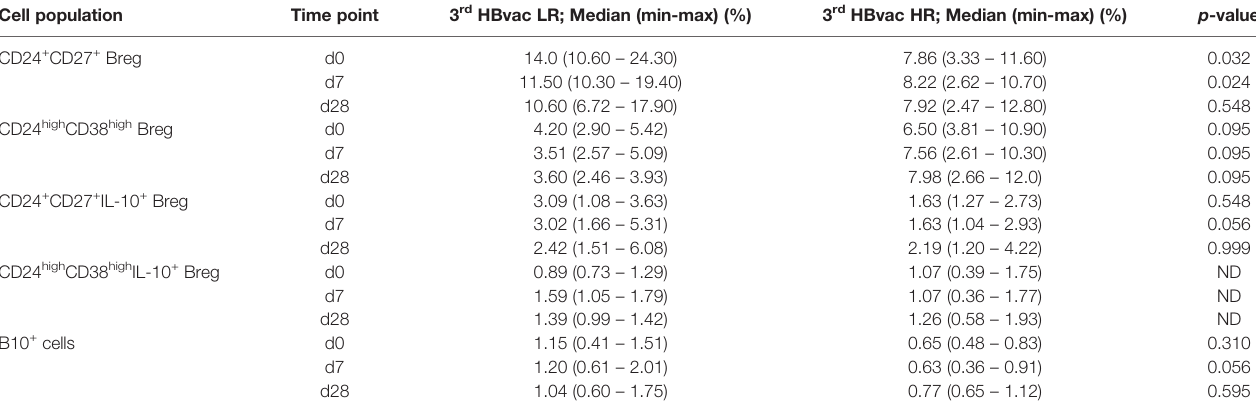
TABLE 3 | Frequencies and cytokine expression levels of CD24 + CD27 + and CD24 high CD38 high Breg and B10 + cells of 3 rd HBvac LR and 3 rd HBvac HR. Cell population Time